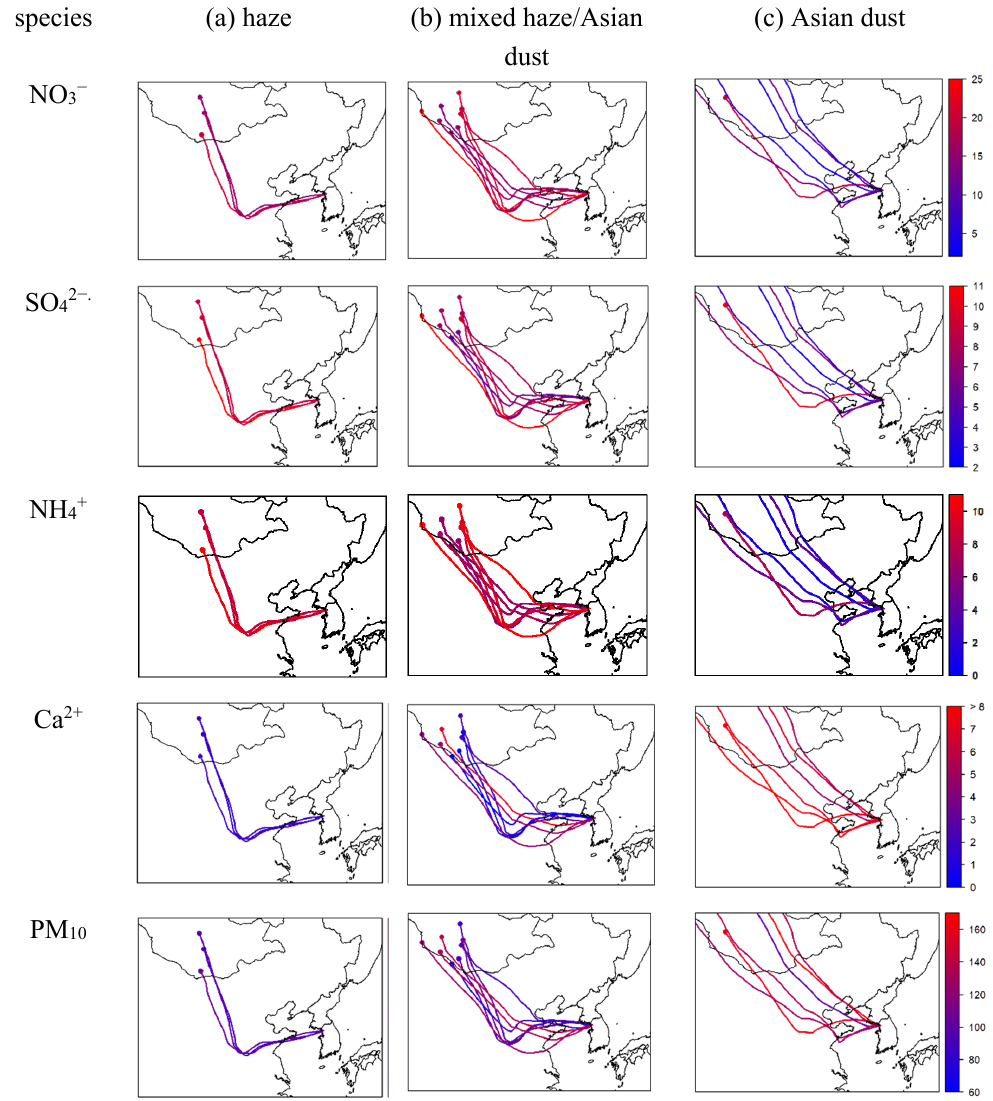
Figure 5. 72 h HYSPLIT backward trajectories at a height of 500 m arriving at the Seoul, colored according to the concentration of pollutants (in µ g m − 3 ) for the ( a ) haze, ( b ) mixed haze / Asian dust, and ( c ) Asian dust episodes.